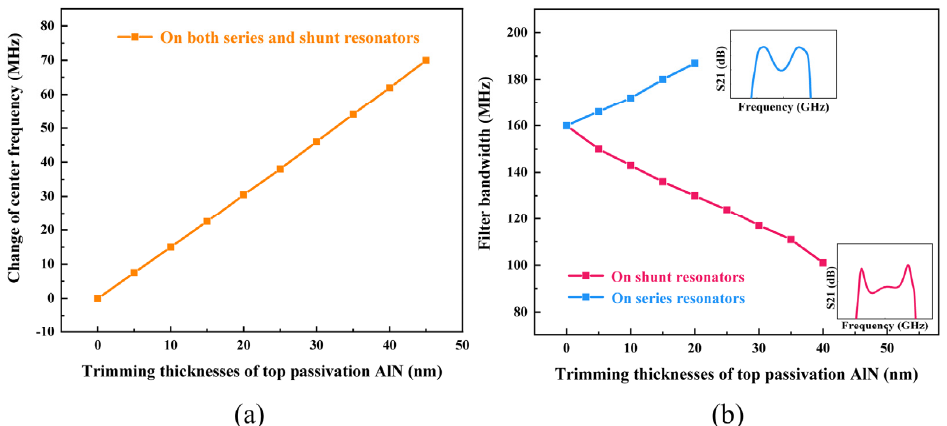
Figure 9. ( a ) Simulated relationship between the change of center frequency and trimming thick- nesses of top passivation AlN on both series and shunt resonators; ( b ) simulated relationship be- tween filter 3-dB bandwidth and trimming thicknesses of top passivation AlN on series or shunt